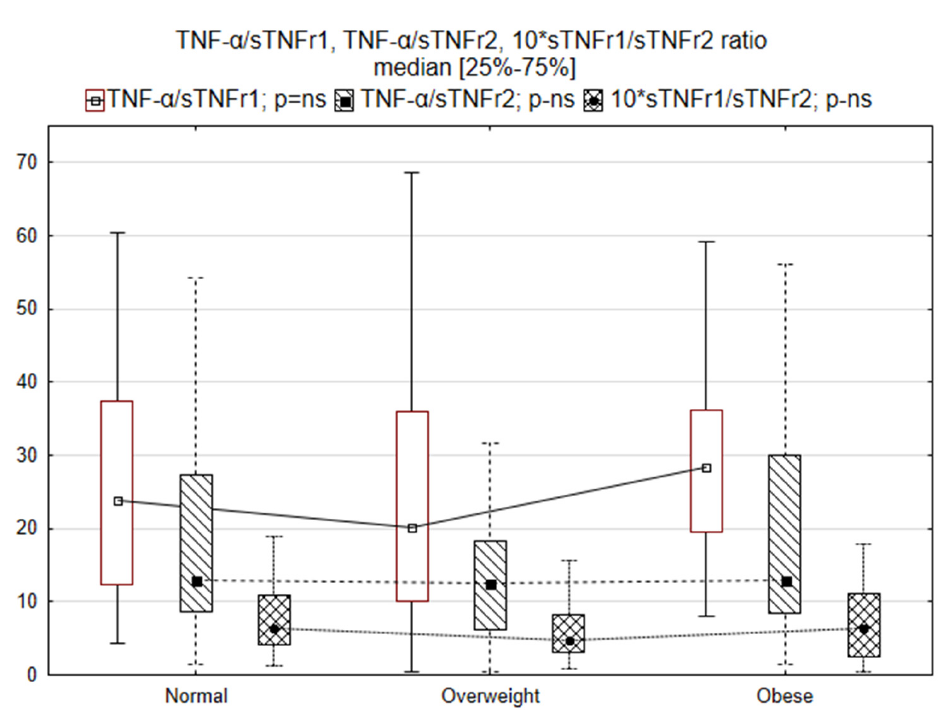
Figure 1. TNF- α /sTNFr1, TNF- α /sTNFr2 and sTNFr1/sTNFr2 ratios in normal-weight, overweight and obese patients.